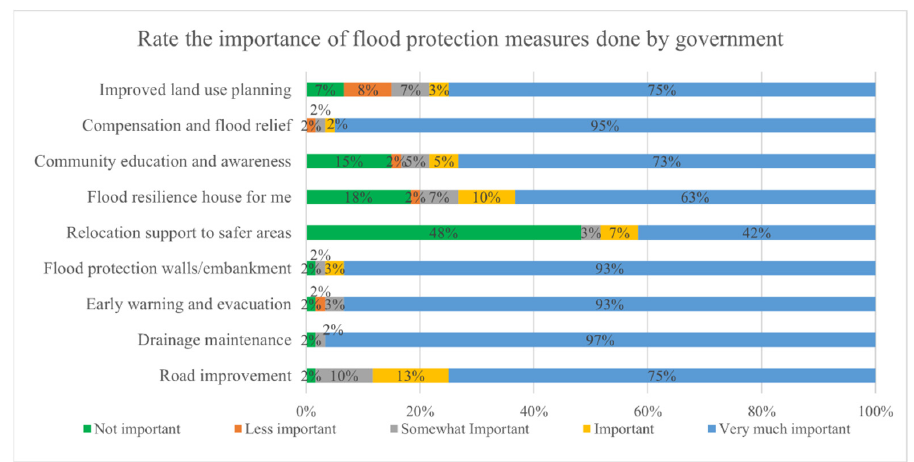
Figure 6. Importance of government flood protection measures in Kolonnawa.